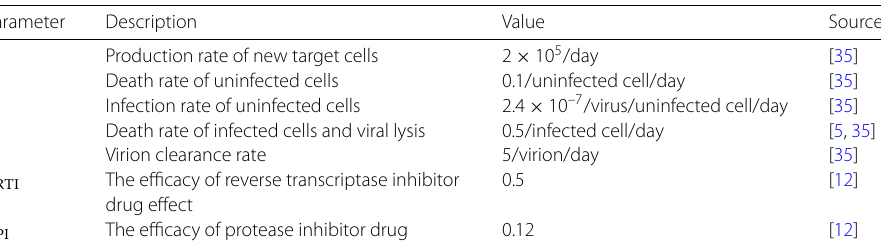
Table 1 List of